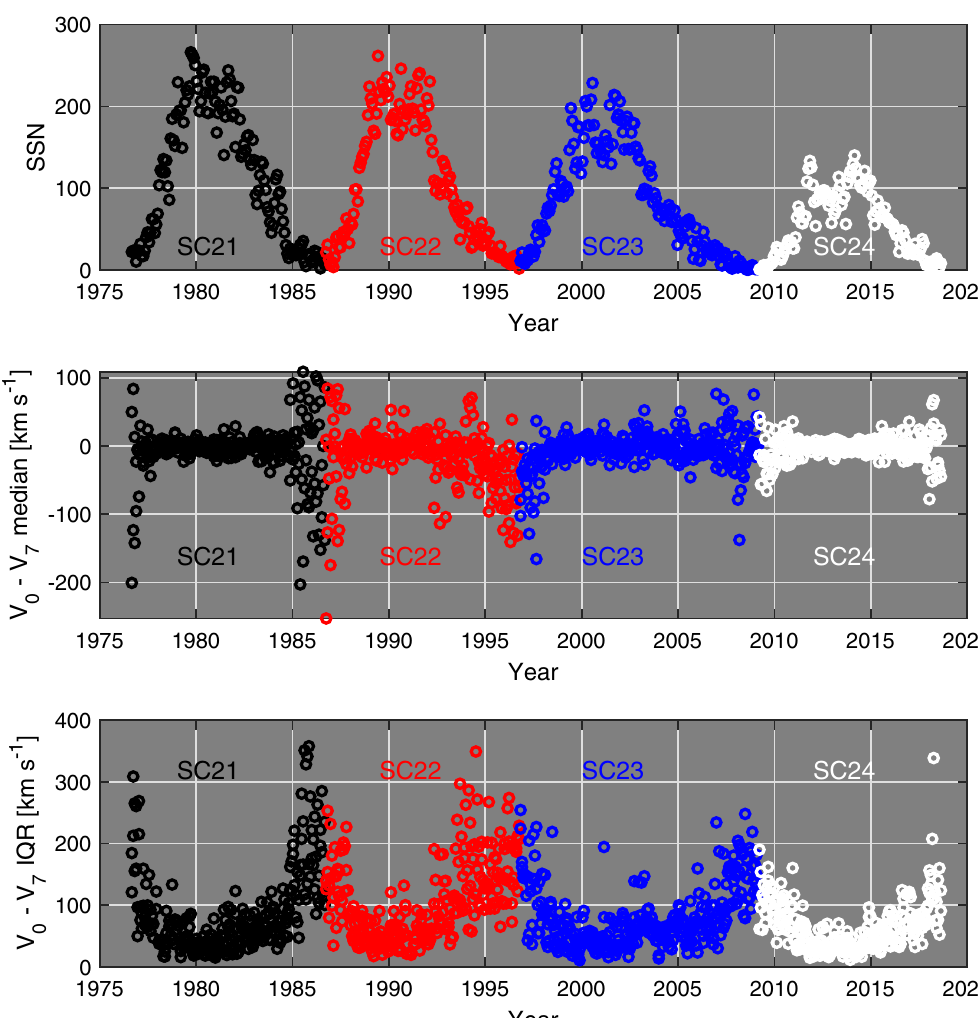
Fig. 4. Time series of 1-CR averages over the period 1975 – 2018. Solar cycles 21, 22, 23, and 24 have been coloured black, red, blue, and white, respectively. Top: sunspot number. Middle: the median value of V 0 (cid:3) V 7 , the solar wind speed difference between the equator and 7 (cid:1) latitude. Bottom: the inter-quartile range of V 0 (cid:3) V 7